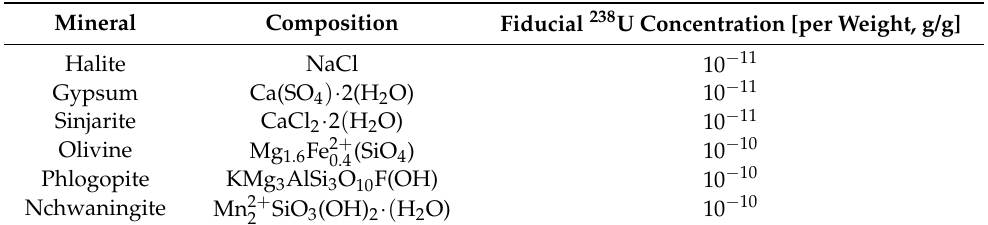
Figure 3. Projected 90% confidence level upper limits in the WIMP mass ( m χ )—spin-independent WIMP-nucleus scattering cross section ( σ SI p ) plane in the high-resolution (sample mass M = 10mg, track length resolution σ x = 1nm; left panel) and high-exposure ( M = 100g, σ x = 15nm; right panel) readout scenarios. The different lines are for different target materials as indicated in the legend; see Table 1. The gray-shaded region of parameter space is disfavored by current upper limits from direct detection experiments [12,14,17,107,150], while the sand-colored region indicates the neutrino floor for a Xe-based experiment [151]. Colors and linestyles are the same in both panels. Table 1. List of minerals considered in this work with their chemical composition and our fiducial assumption for the 238 U concentration ( C 238 ) in radiopure samples of these